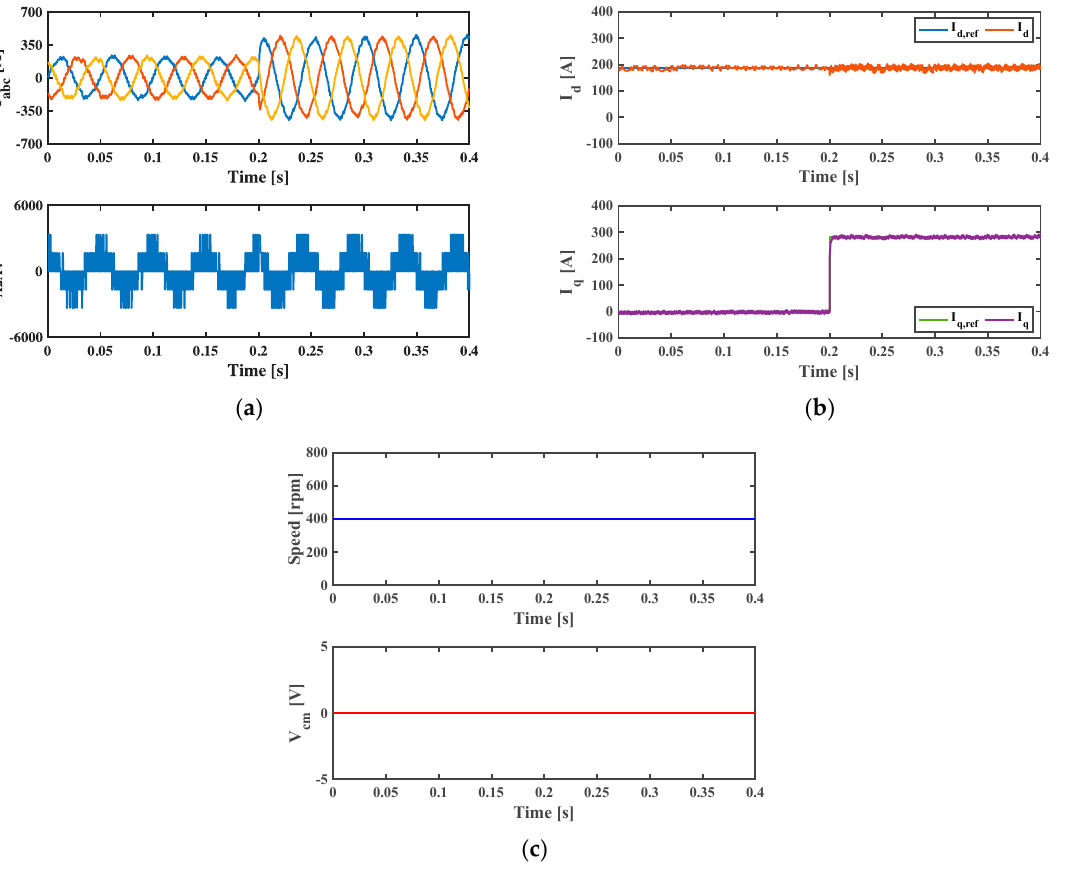
Figure 4. Simulation results for the constant speed and change in the q -axis current. ( a ) Machine currents ( top ) and phase voltage ( bottom ); ( b ) dq -axis currents; ( c ) rotor speed ( top ) and common- mode voltage ( bottom ).